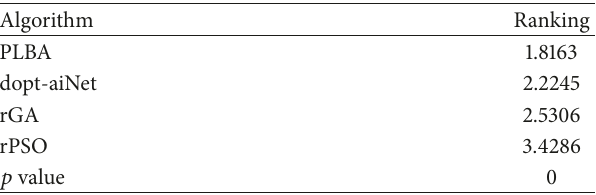
Table 18: Average rankings of PLBA and other comparable algo- rithms(Friedman)ondynamicbenchmarkproblems 𝐹 1 – 𝐹 6 interms of the solution quality.